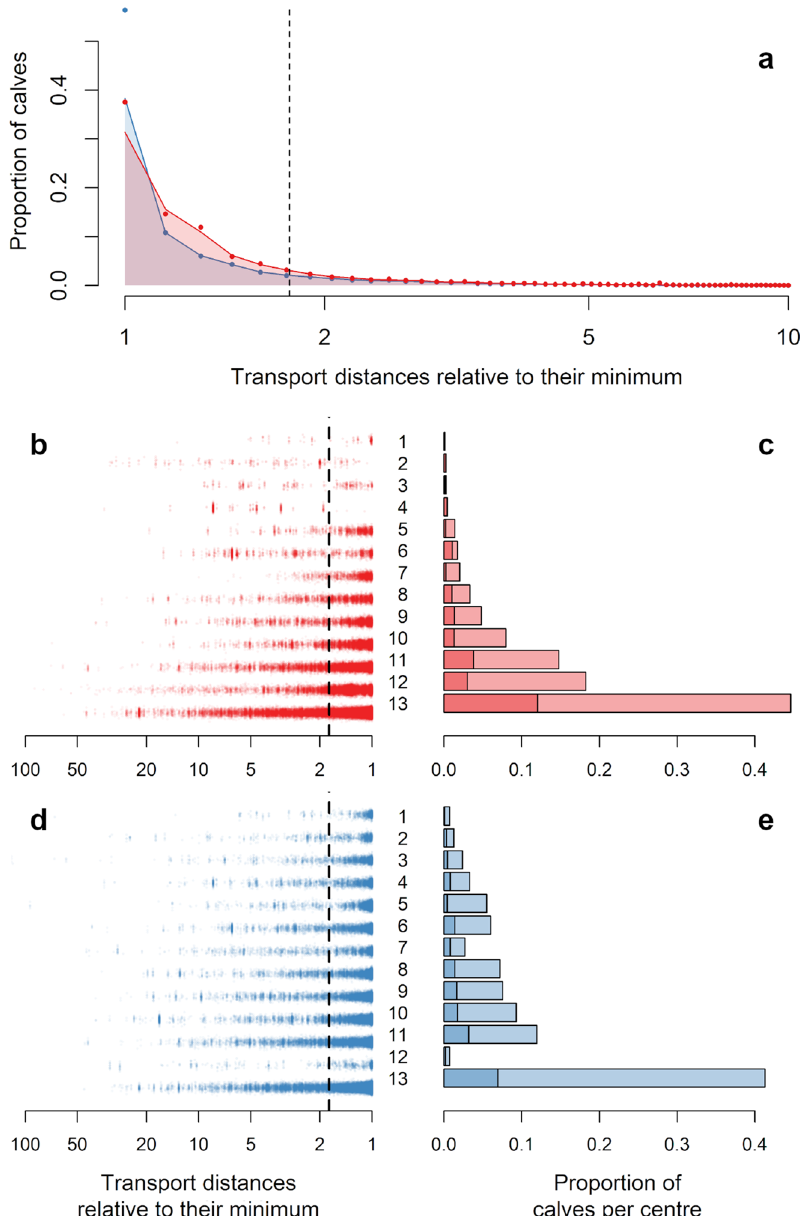
Figure 2. Ratios of historical (red) and optimised (blue) transport distances relative to their minimum (in log scale). ( a ) distribution of the ratios for all the transfers, with a threshold at 1.76 corresponding to the third quartile of the distribution of historical ratios (dashed line). ( b , d ) historical ( b ) and optimised ( d ) ratios per centre (numbered in increasing order of calves assigned historically), with the threshold at 1.76 (dashed line). ( c , e ) proportion of weaned calves going through each centre, according to the historic ( c ) and optimised assignations ( e ), considering all calves (light colours) or only calves whose ratio is greater than 1.76 (dark